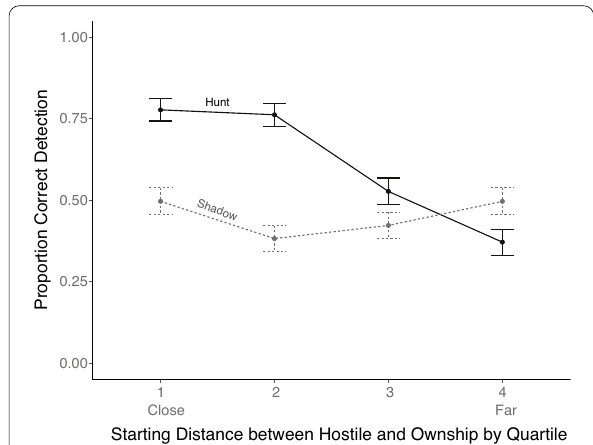
Fig. 6 Joint effects of distance and behavior type on detection accuracy. Error bars represent one standard